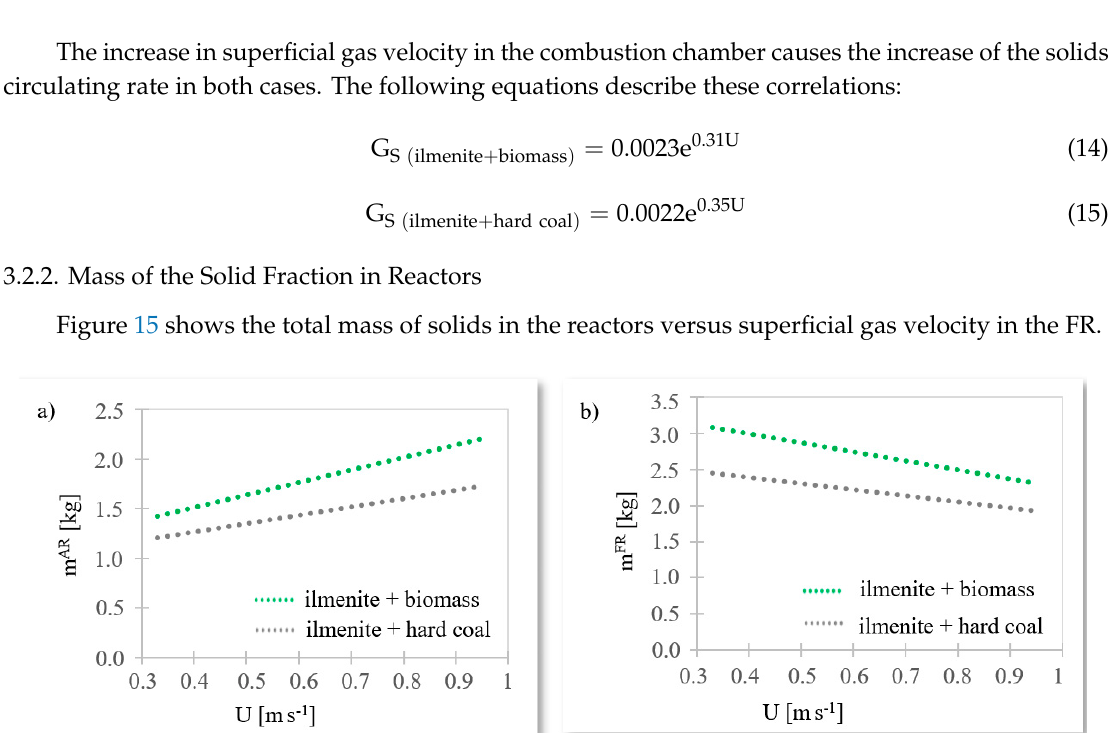
Figure 14. The solid circulating rates of the ilmenite versus superficial gas velocity in the FR.